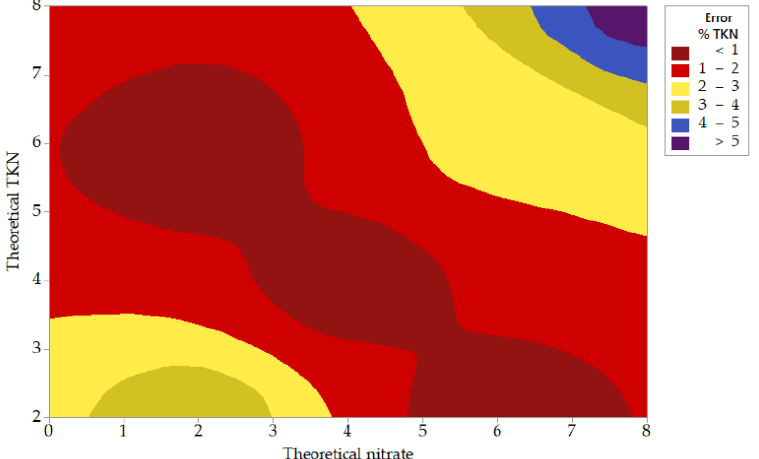
Figure 3. TKN concentrations in mixed standards of Gly-PTSA-nitrate analyzed using the s-TKN TM method and the standard method.